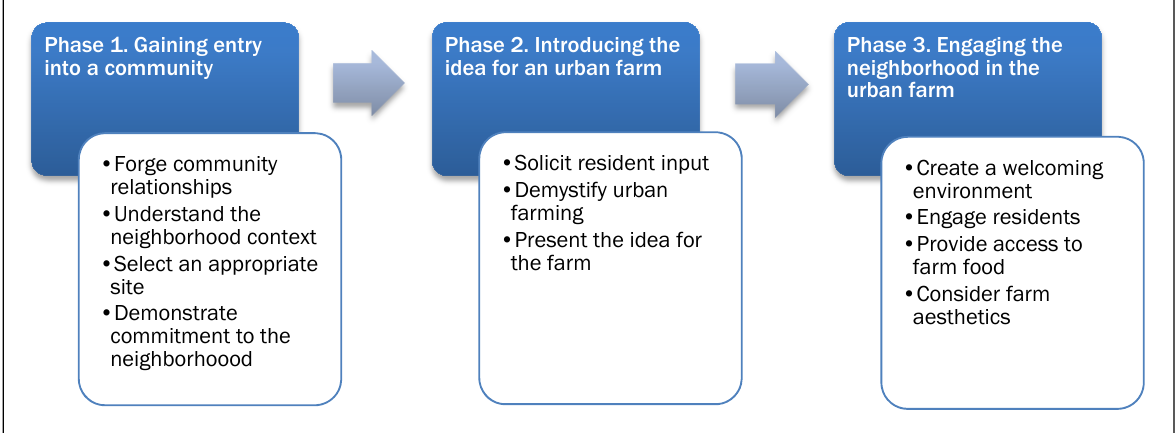
Phase 1. Gaining entry into a